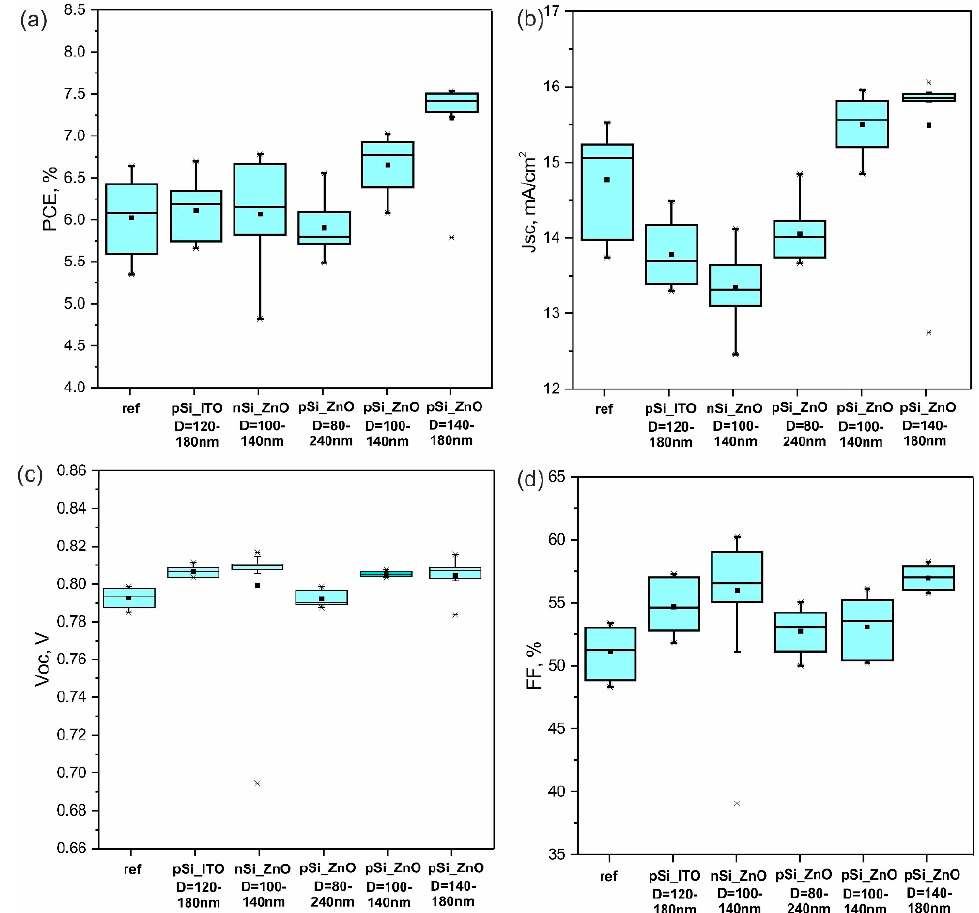
Figure 2. ( a ) PCE, ( b ) Jcs, ( c ) Voc, and ( d ) FF statistical data for photovoltaic performance of individual devices under 1 sun illumination for reference solar cells and for similar solar cells with different positions (on ITO or ZnO), diameters (D), and type of doping (nSi or pSi) of Si NPs. From left to right: reference cells without Si NPs; pSi NPs on ITO; nSi on ZnO; pSi NPs with D = 80–240 nm on ZnO deposited via spray-coating; pSi NPs with D = 100–140 nm on ZnO deposited via spin-coating with a concentration of 6 × 10 − 4 mol L − 1 ; and pSi NPs with D = 140–180 nm on ZnO deposited via spin-coating with a concentration of 3 × 10 − 4 mol L − 1 .